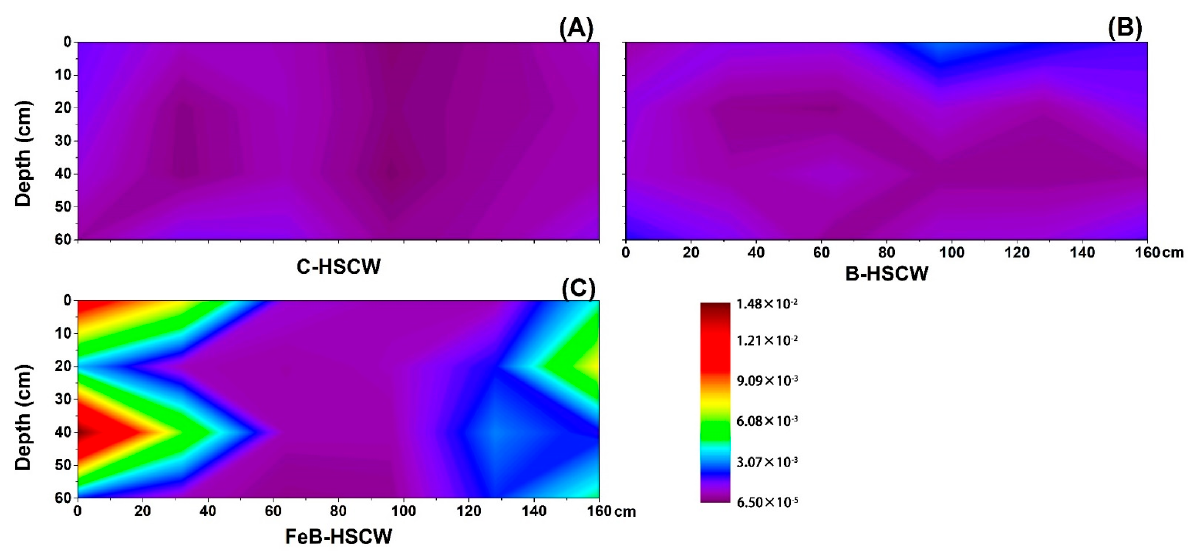
Figure 10. The spatial distribution of nosZ -I relative abundance in C-HSCW ( A ), B-HSCW ( B ), and FeB-HSCW ( C ) based on interpolated maps. Color scales indicate extrapolated values by kriging. C-HSCW, without biochar and FeB-modified biochar; B-HSCW, with biochar; FeB-HSCW, with FeB-modified biochar.